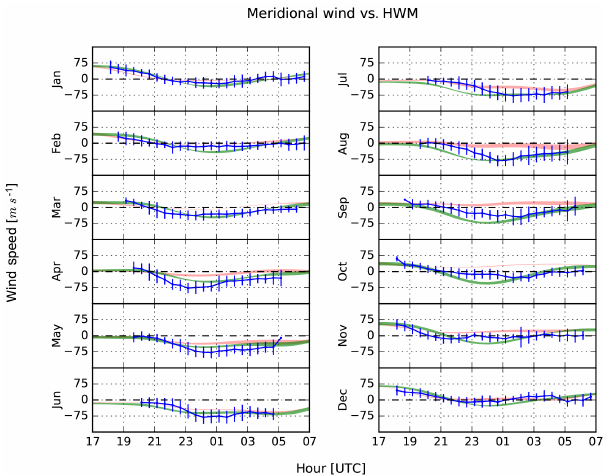
Figure 4. Monthly averages of meridional winds from January 2014 until February 2016 (blue). Airglow-weighted model results from HWM07 (red) and HWM14 (green). Positive values are northward.